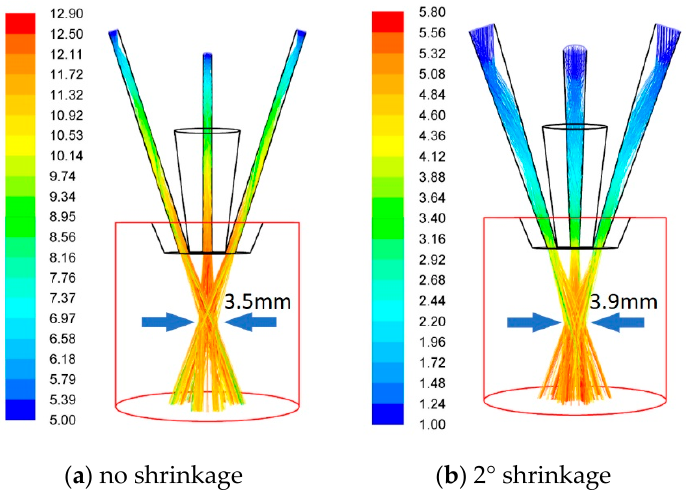
Figure 9. Powder focus spot diameters with and without passage shrinkage. ( a ) no shrinkage; ( b ) 2° shrinkage.